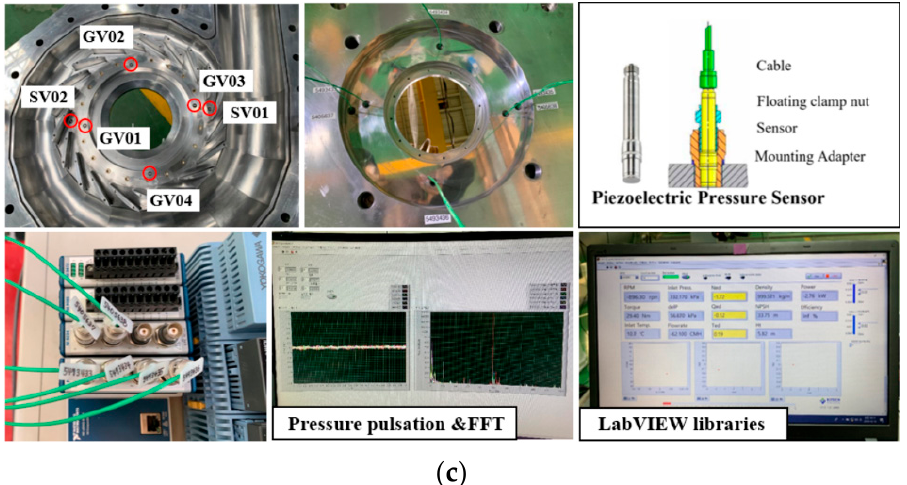
Figure 5. Test facilities for performance evaluation: ( a ) Schematic of the experimental apparatus; ( b ) manufactured main components; ( c ) measurement of pressure pulsation setup and data extraction.